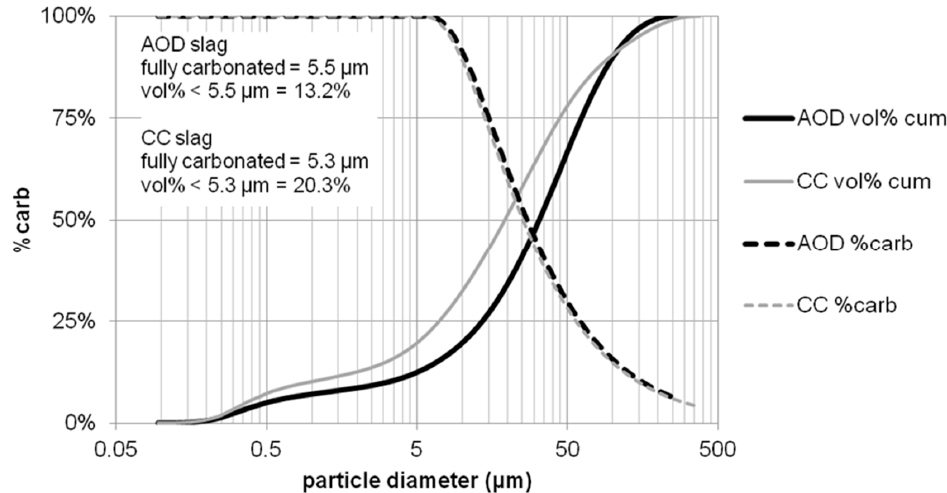
Figure 8. Particle size distribution of fresh AOD and CC slags (vol % cum), determined by laser diffraction, and modelling results of particle carbonation conversion degrees (%carb) [39].